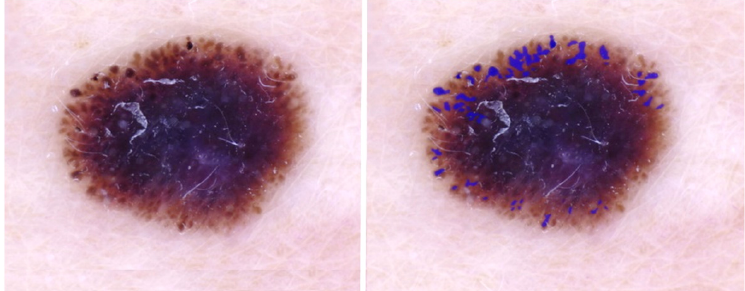
Figure 3. IoU = 0.0; DL detects extra structures: globules and pseudopods in the periphery. In all figures, blue regions signify false-negative areas, green regions are false-positive, and teal-colored regions are true-positive.